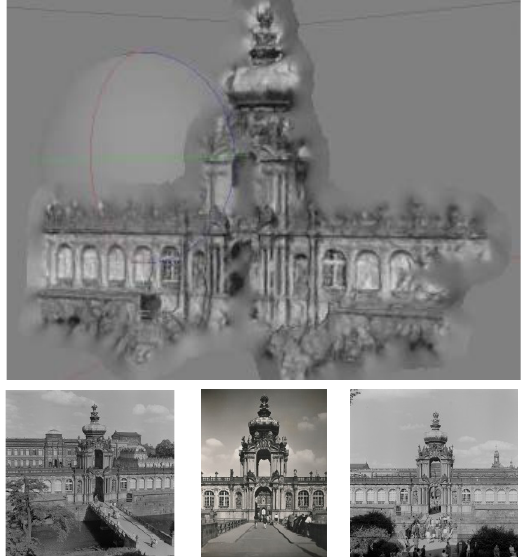
Figure 1. 3D model based on current and historical